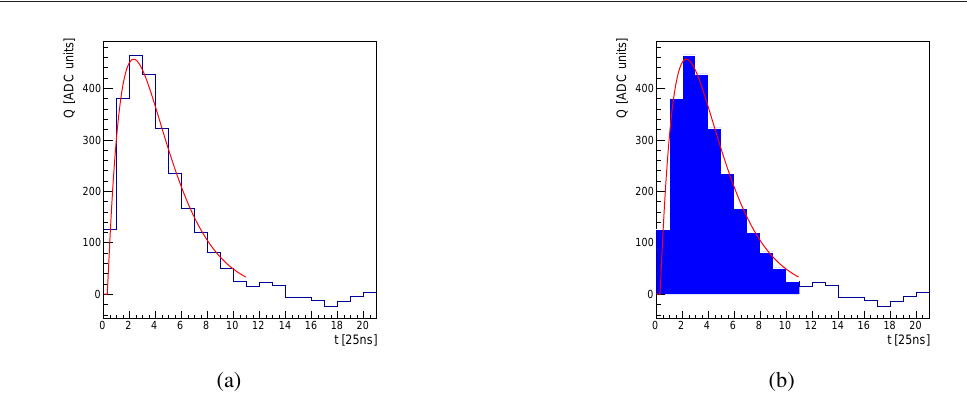
Figure 3: a) A signal of one channel with the result of fitting. b) The signal with the result of fitting (red line) and the area that is equal to the Σ (filled